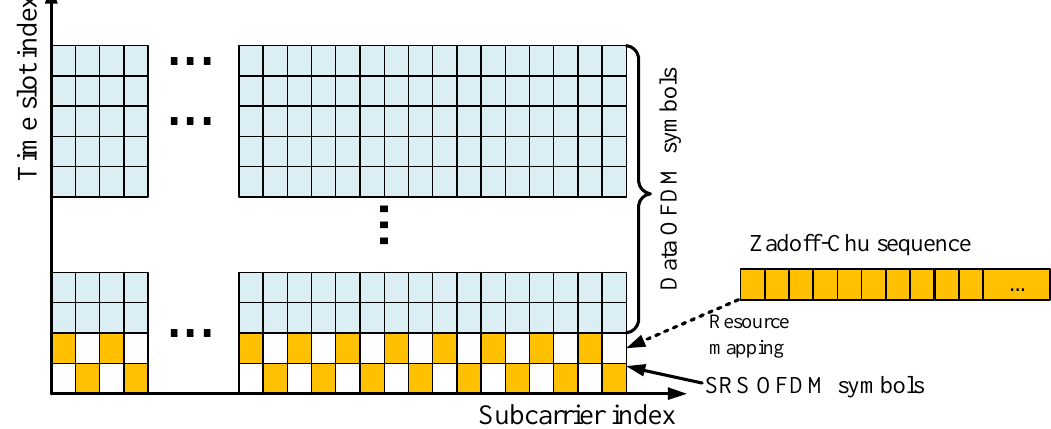
Figure 2. Simplified SRS generation: to map a Zadoff–Chu sequence (orange grids) to the specified subcarriers and time